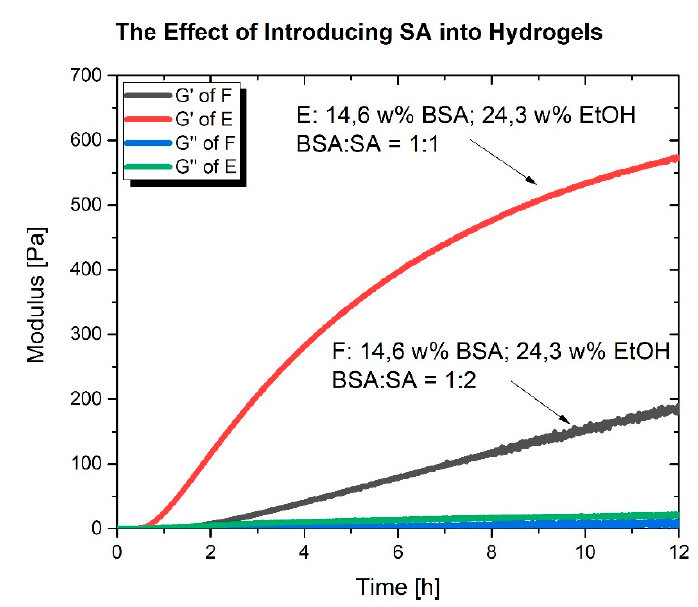
Figure A2. Addition of stearic acid (SA) into the precursor solution of the gels (2.1 mM BSA solution) leads to weakening the mechanical properties of the gels. The SA were dissolved in 0.1 M KOH prior to addition into precursor solution.